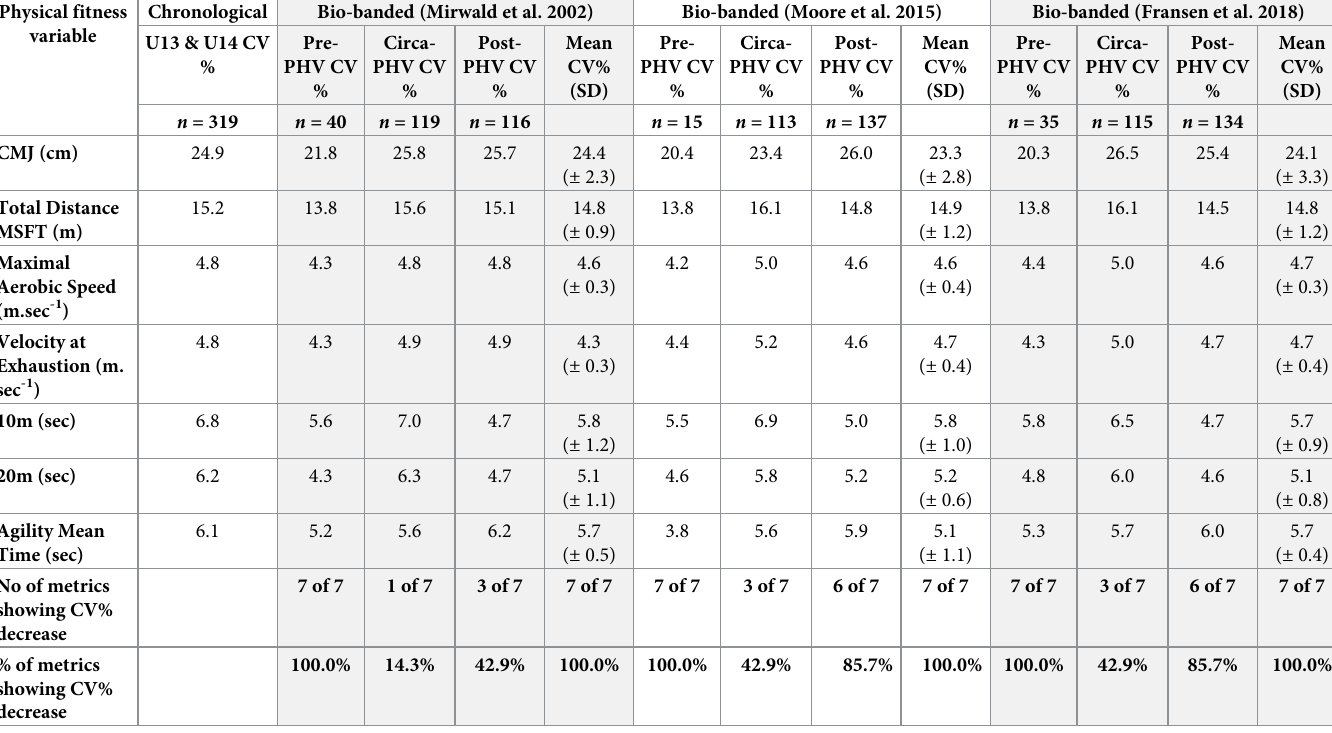
Table 3. Summary table of the coefficient of variance (CV%) for U13 and U14 academy soccer players physical fitness characteristics when categorised using an aggregated chronological age group or three different Mirwald, Baxter-Jones [23], Fransen, Bush [24] and Moore, McKay [29] bio-banding (pre-PHV, circa-PHV and post-PHV) methods.